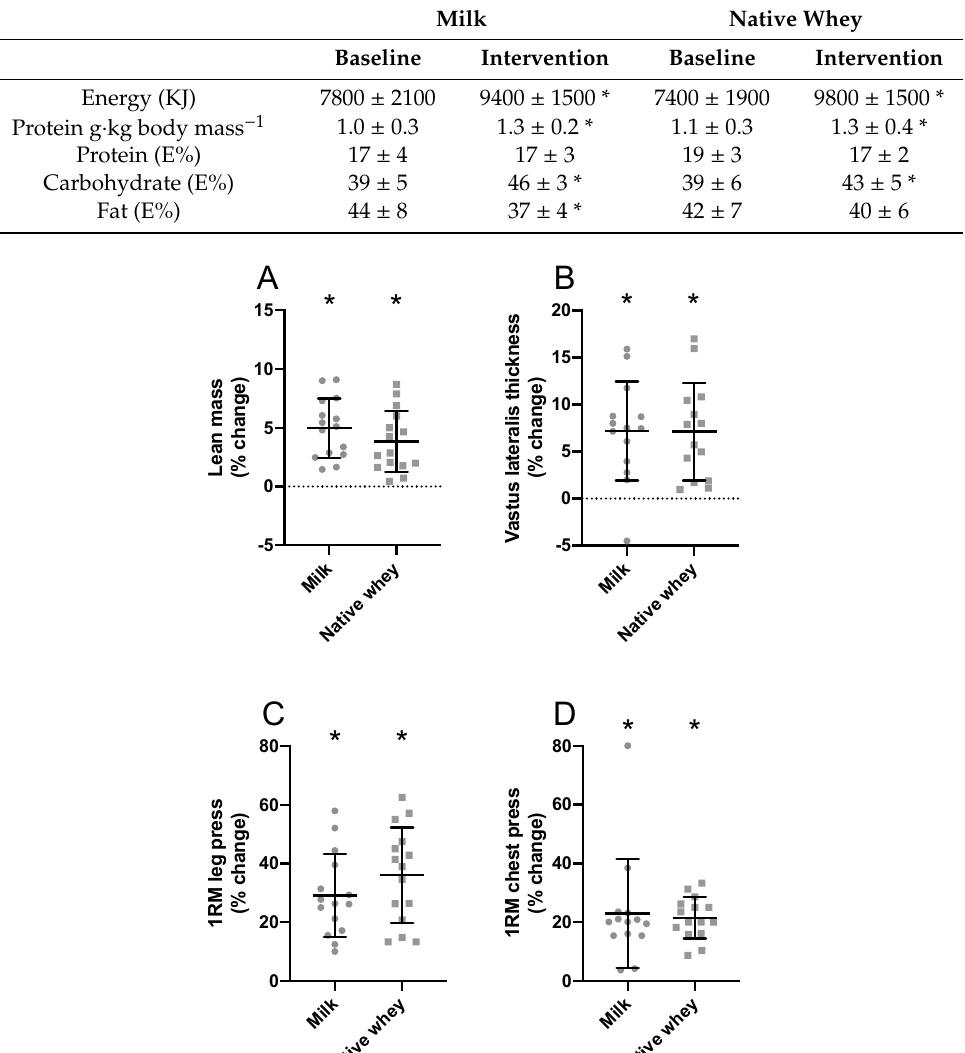
Table 3. Daily intakes of energy and macronutrients before and during the training intervention. Values are averaged from two 24-h recall interviews. * signifies change from pre. Significance level at p ≤ 0.05.